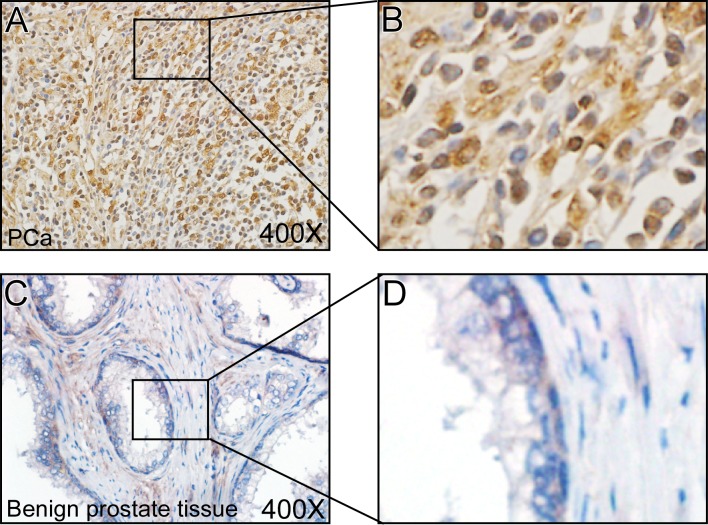
Med19 expression level was elevated in PCa tissues.Med19 IHC staining was performed in 10 pairs of PCa and adjacent benign prostate tissues. The Med19 expression level was much higher in PCa tissues (A, B) than in adjacent benign tissues (C, D). (A) and (C) were taken at 400×magnification, (B) and (D) were local amplified pictures.